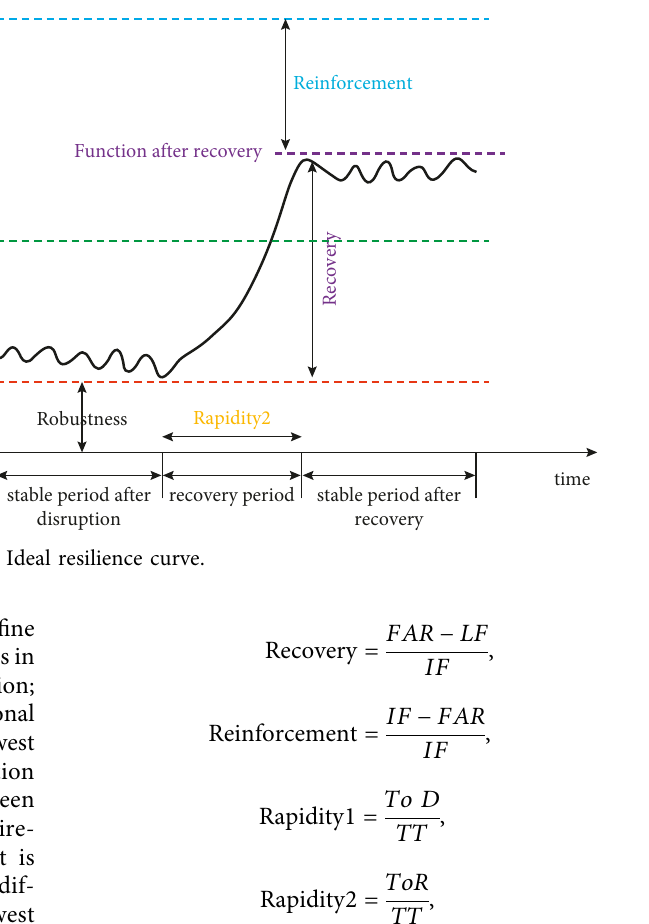
Figure 6: Ideal resilience